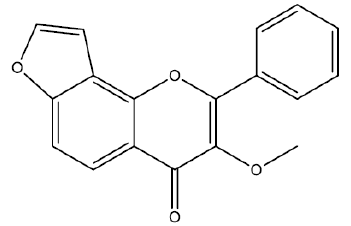
Figure 7. Furanoflavonoids (karanjin) with gastroprotective and/or anti-ulcer activity.